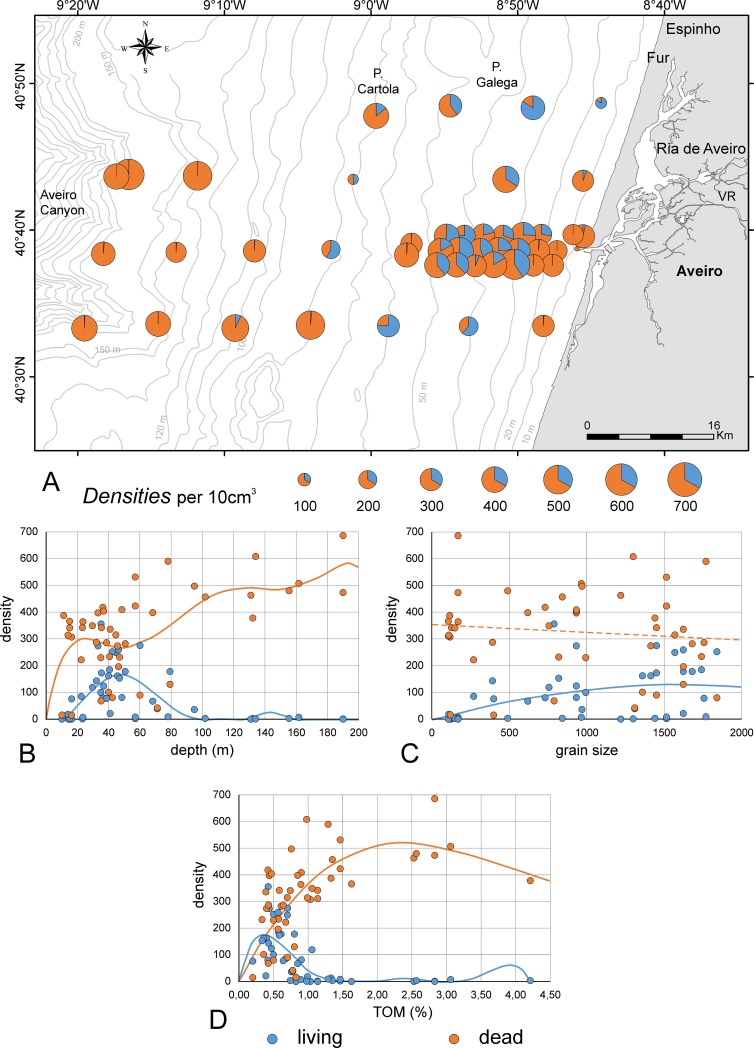
Densities of assemblages in the investigated area.A. Densities of living and dead individuals represented as pie charts. B. Dependence of densities from depth fitted by 6th order power functions. C. Dependence of densities from grain size fitted by 2nd order power functions (living) and linear regression. D. Dependence of densities from TOM fitted by 6th order (living) and 3rd order (dead) power functions. Full line: significant correlation; broken line: non-significant correlation.